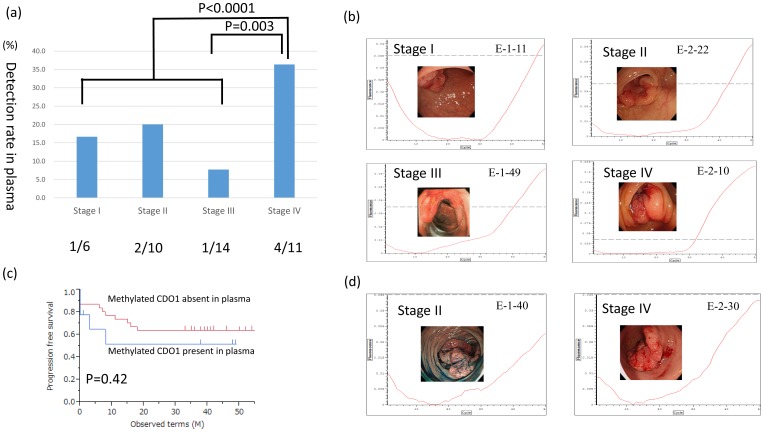
Detection rate of methylated CDO1 in the plasma of patients with CRC using a high volume of plasma-derived DNA template.(a) Q-MSP analysis of methylated CDO1 using a high amount of plasma-derived DNA of CRC patients at differential stages. (b) Representative positive cases are shown according to stage. A picture of colon fiber in the primary cancer is included in each figure. (c) Survival curve of CRC patients according to methylated CDO1 levels in the plasma. (d) Representative cases showing marginal positive case are shown.